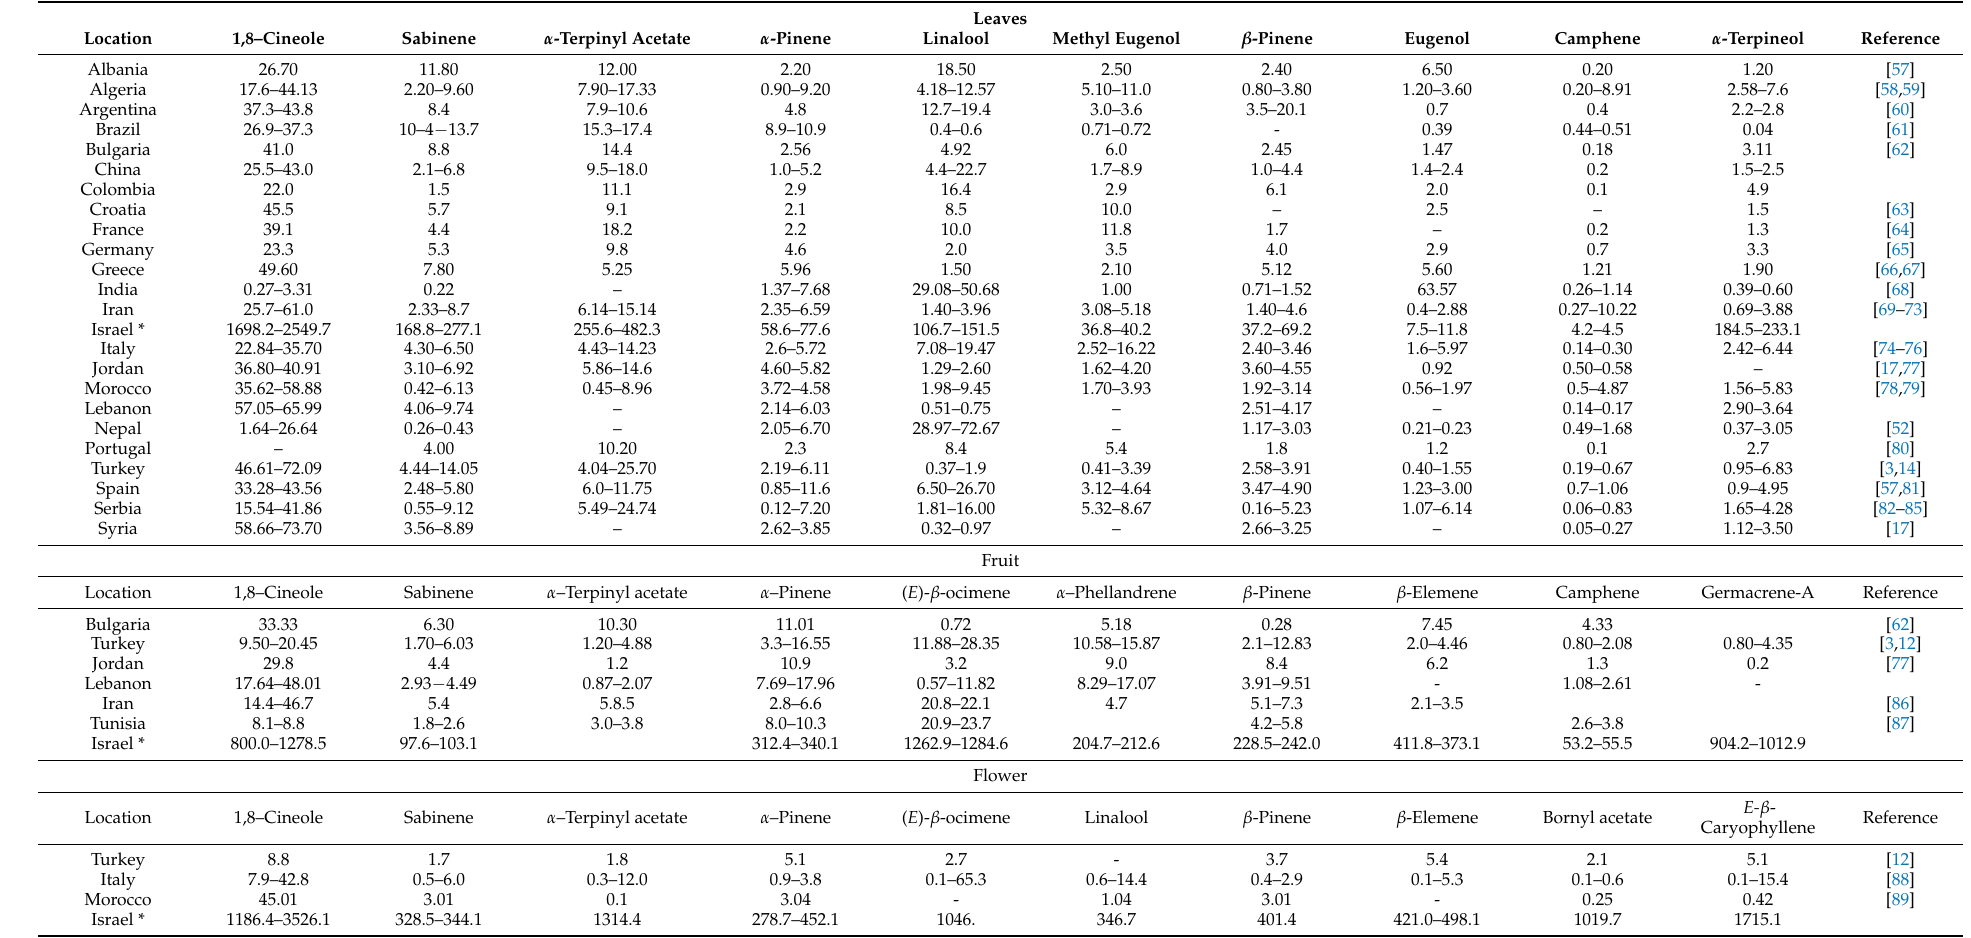
Table 2. Variation in the major volatile composition from essential oils (%) of bay plant parts from different geographic